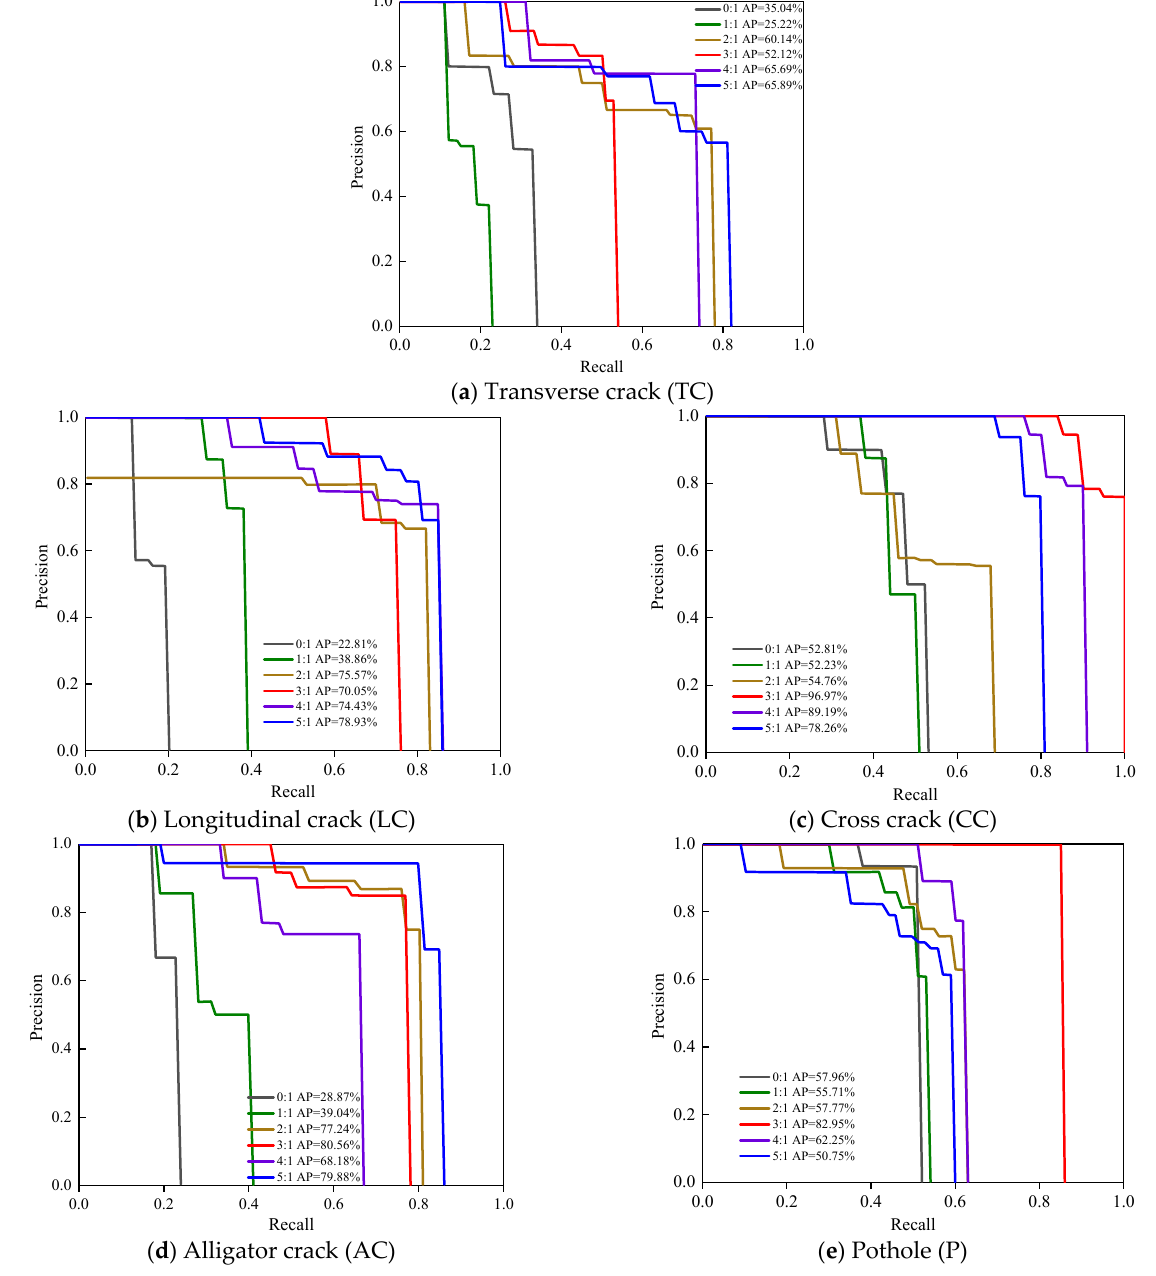
Figure 12. Precision-recall curves of five types of defects based on integrated datasets with different virtual-to-real ratios. Detection results of YOLOv5 network for ( a ) transverse cracks ( b ) longitudinal cracks ( c ) cross cracks ( d ) alligator cracks ( e ) potholes. Table 5. The MAP of the YOLOv5 network trained using a different number of real